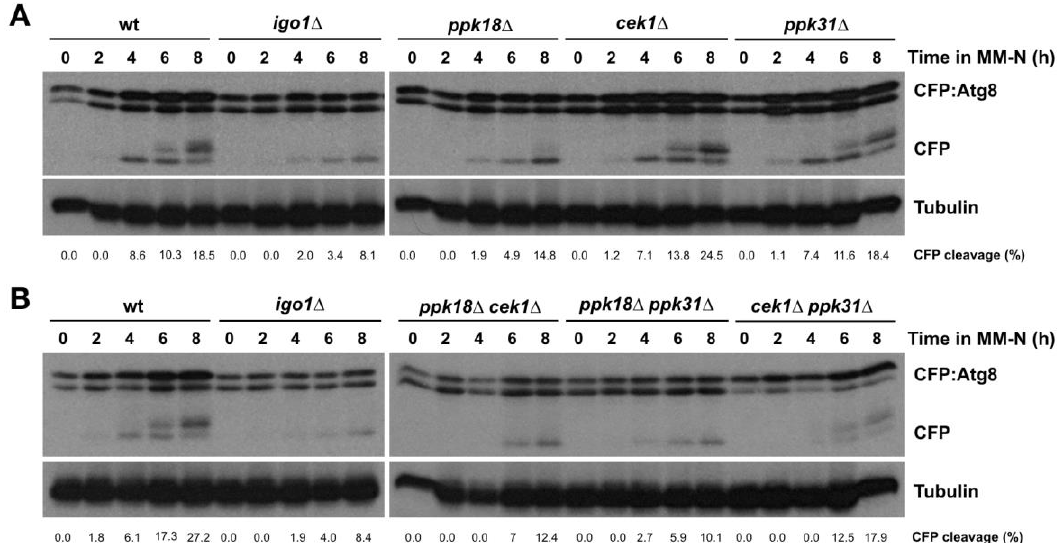
Figure 4. The Greatwall – Endosulfine switch promotes autophagy. ( A ) Wild type, igo1 ∆ , ppk18 ∆ , cek1 ∆ , and ppk31 ∆ cells expressing CFP:Atg8 were grown in minimal medium at 25 °C until mid- exponential phase and then transferred to nitrogen-free minimal medium (MM-N) for 8 h at 25 °C. Samples were taken at 0, 2, 4, 6, and 8 h in MM-N. ( B ) Wild type, igo1 ∆ , ppk18 ∆ cek1 ∆ , ppk18 ∆ ppk31 ∆ , and cek1 ∆ ppk31 ∆ cells expressing CFP:Atg8 were grown in minimal medium at 25 ◦ C until mid- exponential phase and then transferred to nitrogen-free minimal medium (MM-N) for 8 h at 25 ◦ C. Samples were taken at 0, 2, 4, 6, and 8 h in MM-N. CFP:Atg8 and free CFP levels were determined using anti-GFP antibodies (Clontech). Tubulin was used as a loading control. The percentage of CFP cleavage is indicated under the